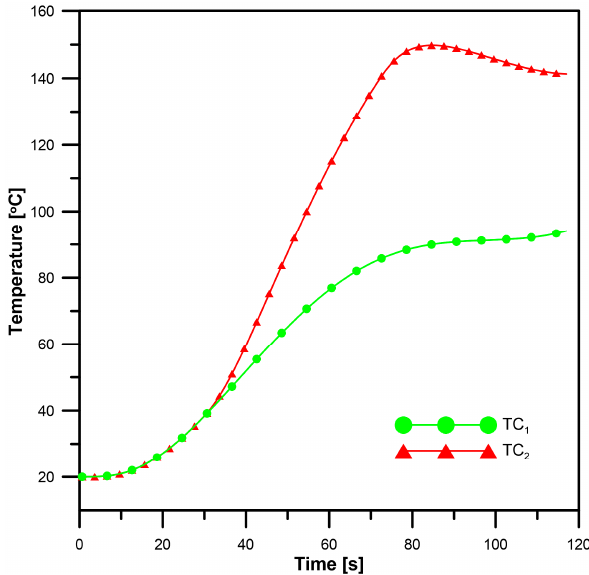
Figure 15. “Measured” temperature histories in points TC 1 and TC 2 .